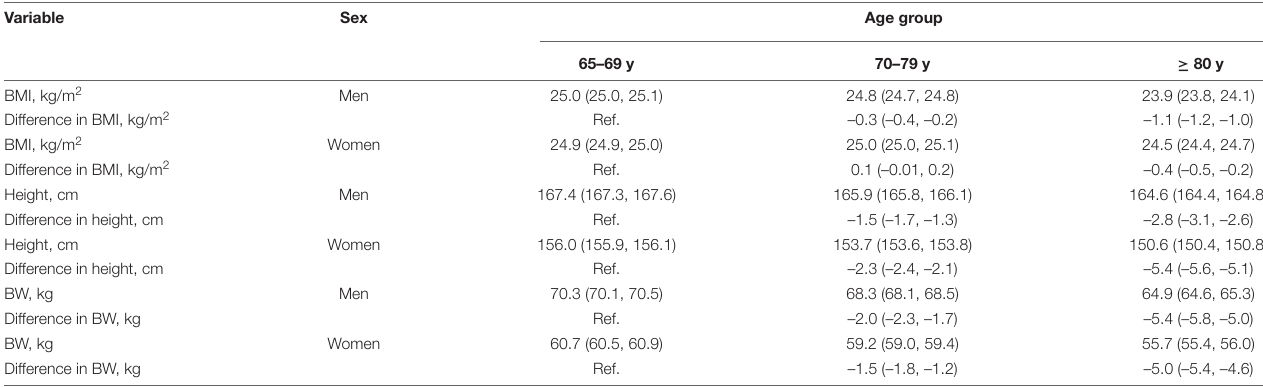
BMI, body mass index; BW, body weight. The difference between the age groups was tested by linear regression